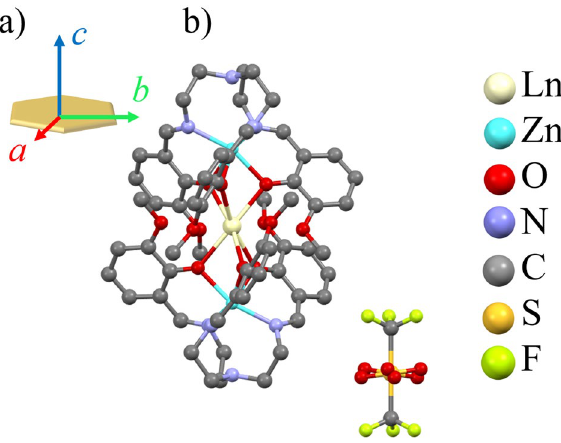
Figure 1. ( a ) The orientation of the monocrystal with the real space directions. ( b ) Crystal structures of the Ln III (Zn II L) 2 unit with Ln III = Tb III ( Tb-SMM ), Dy III ( Dy-SMM ) and the CF 3 SO 3− anion. The view is along a axis, and hydrogen atoms are omitted for clarity. The CF 3 SO 3− anion is disordered in two positions related by C 2 axis, each with an occupancy of 0.5.